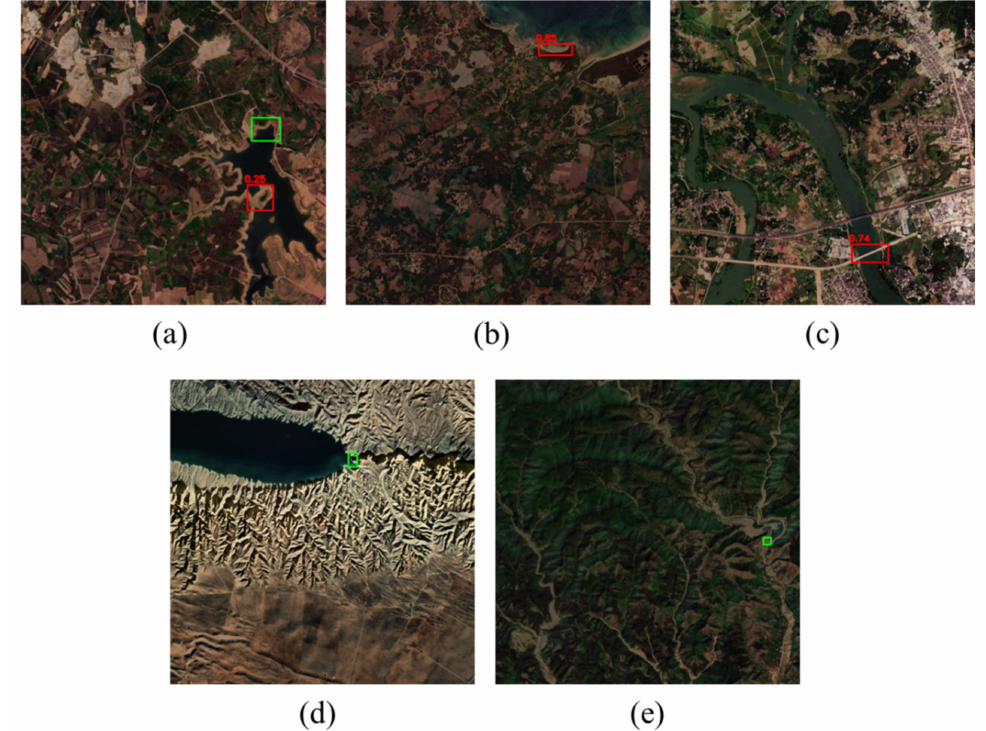
Figure 16. Visualization of some bad cases in detection results. Red bounding boxes denote prediction of the model, while green bounding boxes denotes ground truth annotated. ( a ) A unique-shape reservoir; ( b ) beach; ( c ) bridge; ( d ) a reservoir under complex landforms; ( e ) a small reservoir.